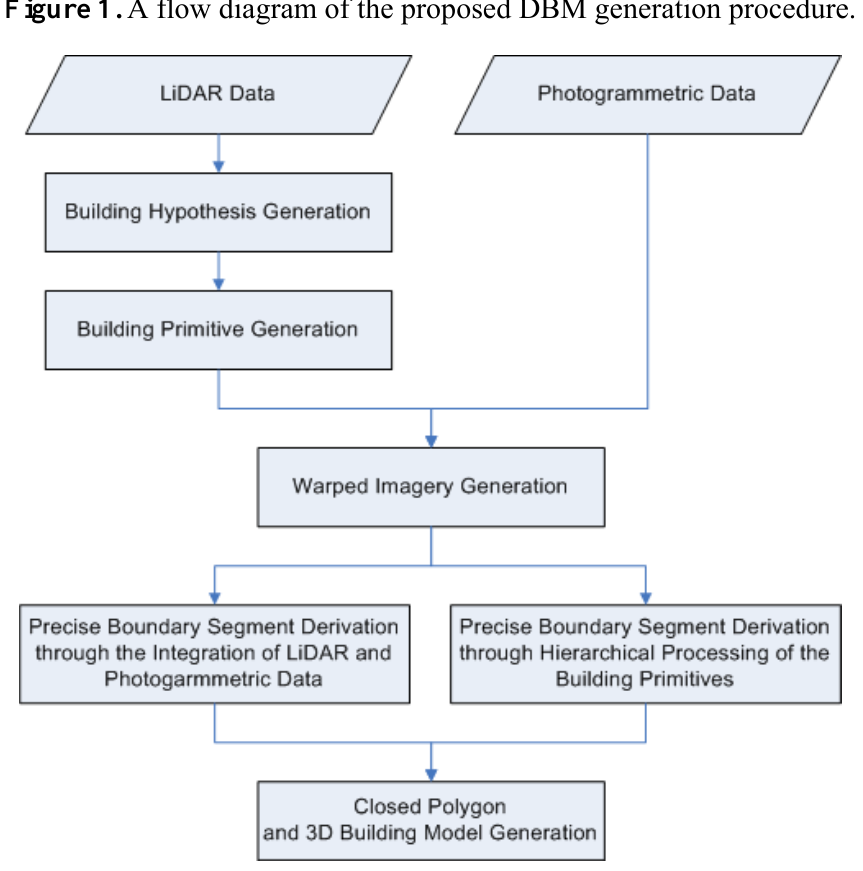
Figure 1. A flow diagram of the proposed DBM generation